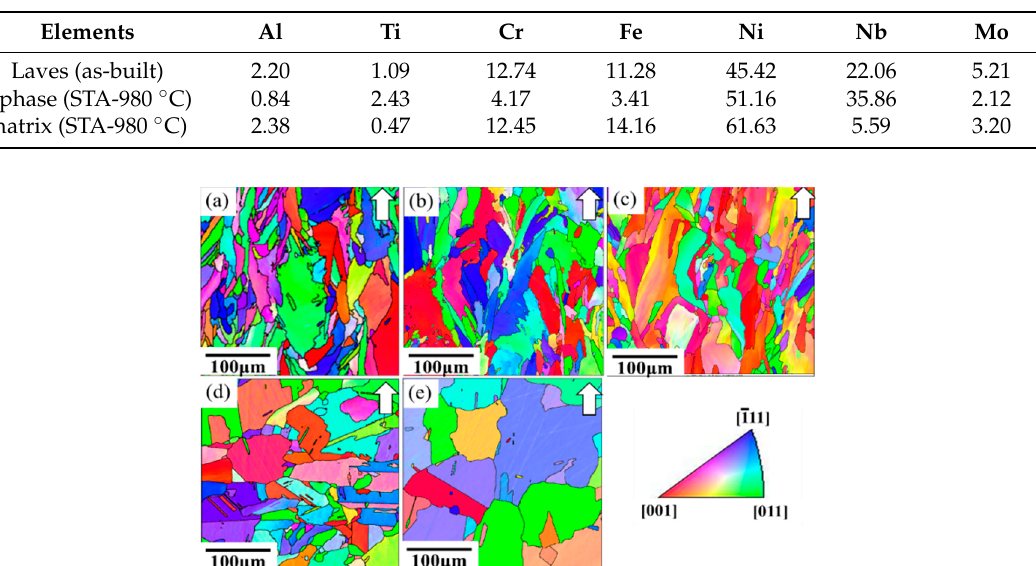
Figure 5. IPFs of ( a ) STA-980 °C, ( b ) STA-1045 °C, ( c ) STA-1065 °C, ( d ) STA-1120 °C, and ( e ) STA-1180 °C/1 h specimens were analyzed using the orientation measurements by EBSD. The building directions are shown by arrows.